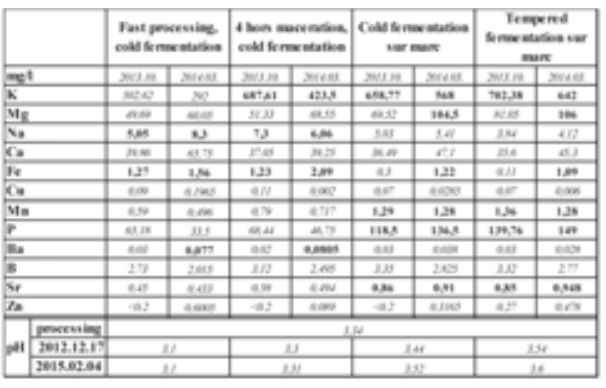
*missing data from technical reason Table 5 . Data on element composition and pH of ’Medina’ wines in respect to differentiated fermentation